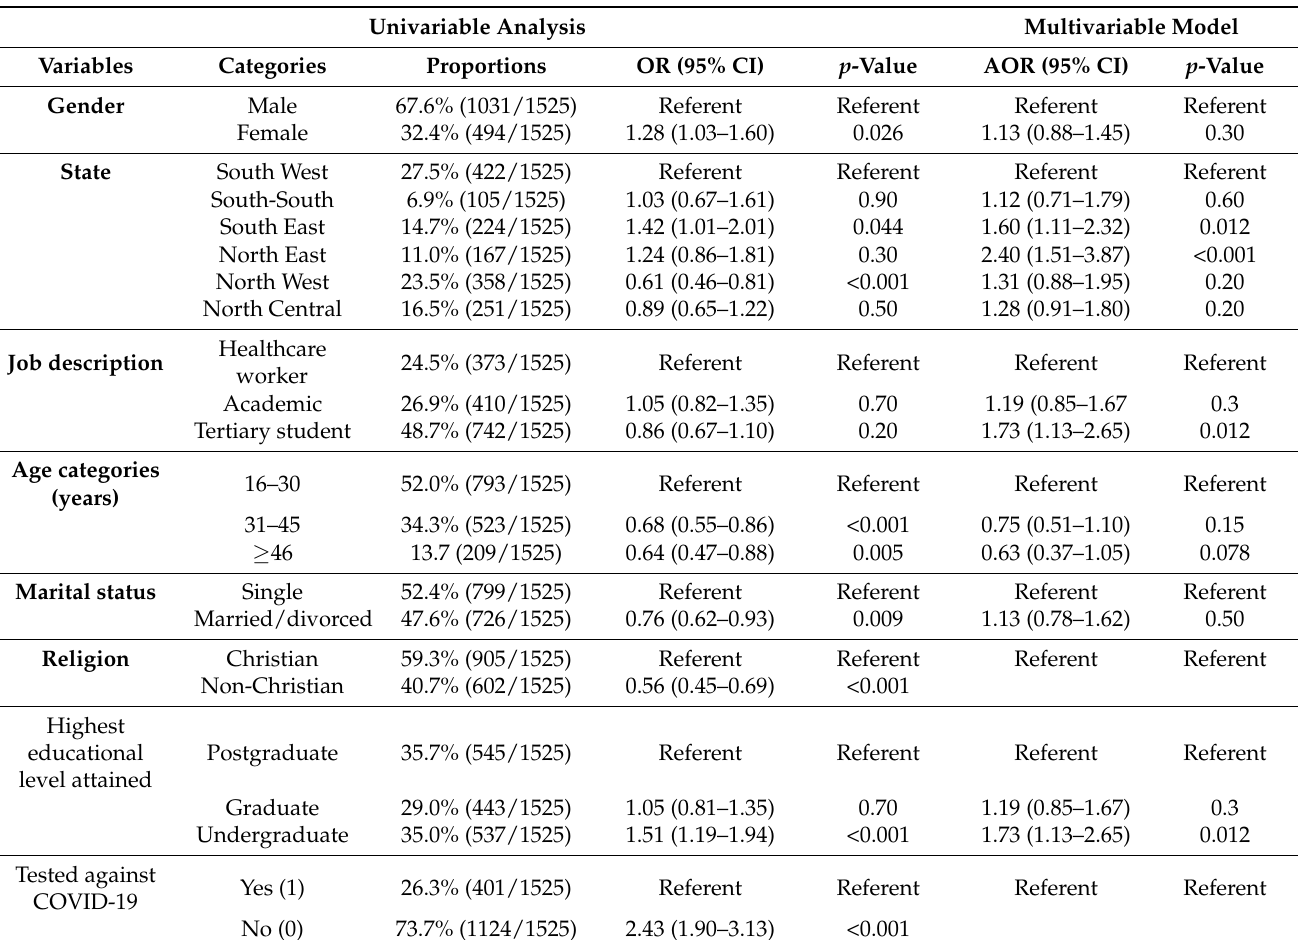
Table 3. Univariable and multivariable results of variables associated with COVID-19